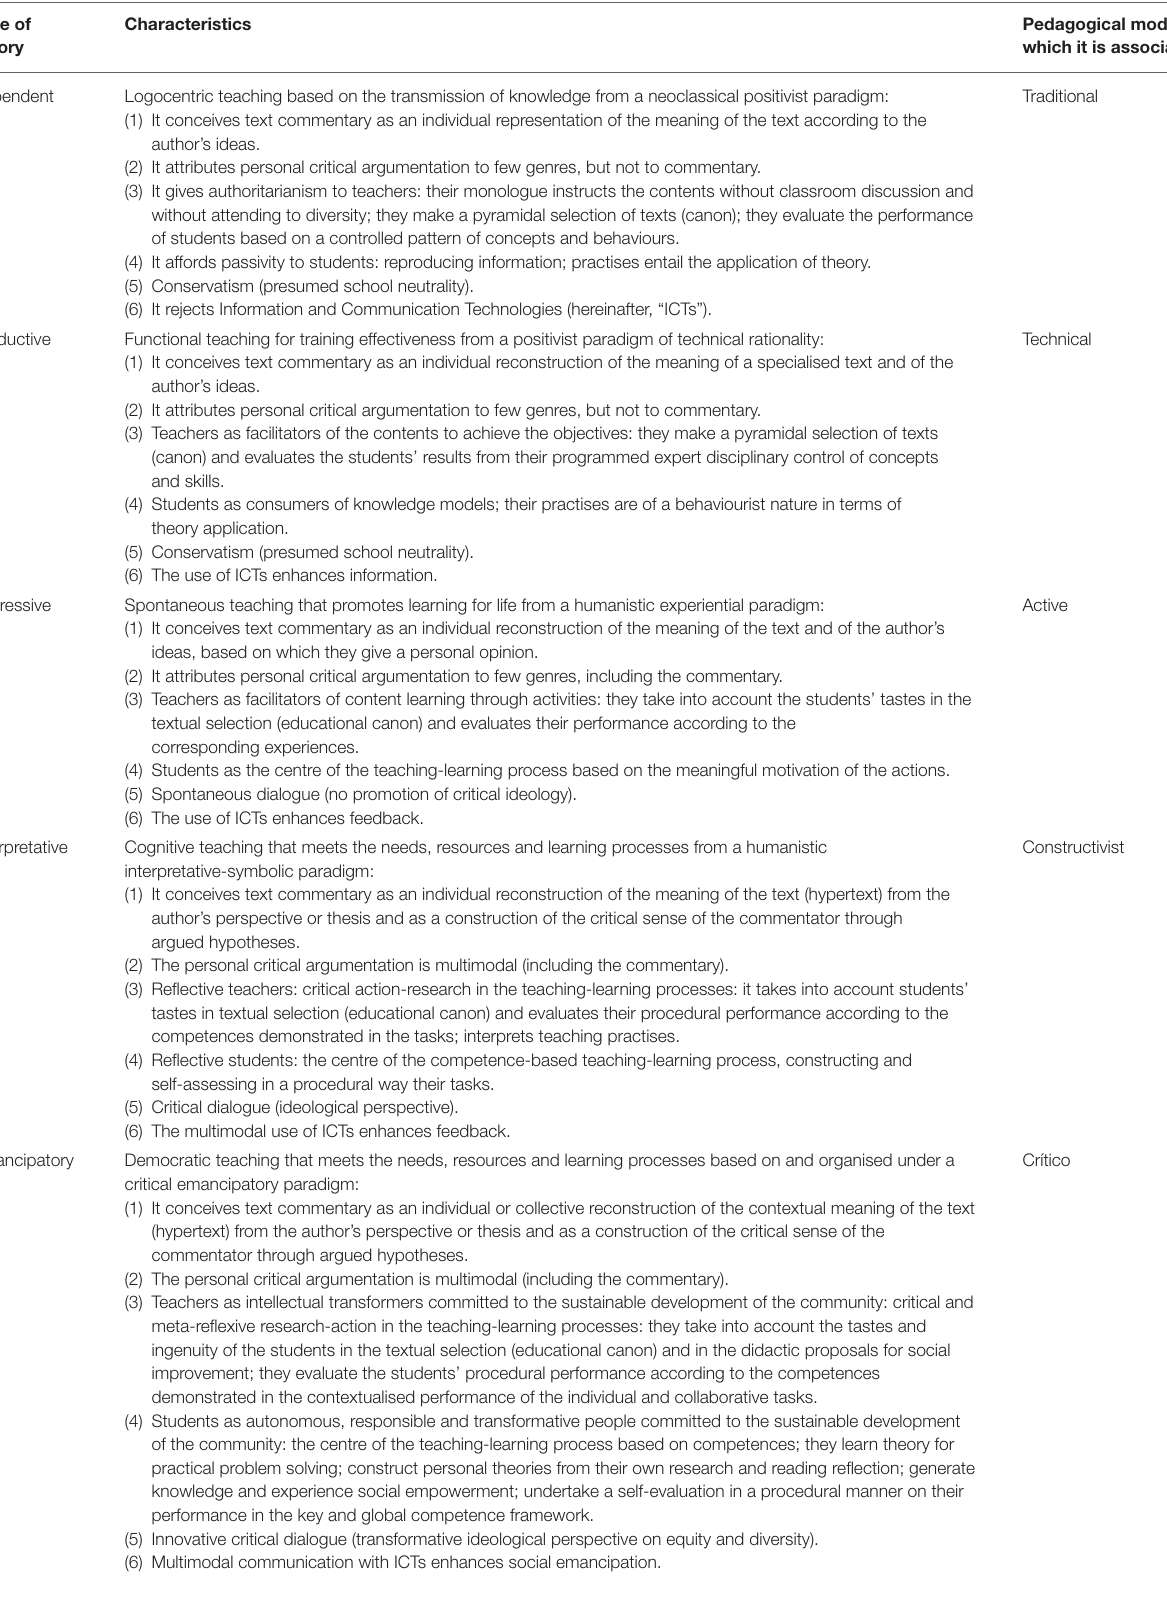
TABLE 2 | Classification of implicit teacher theories (Caro et al.,